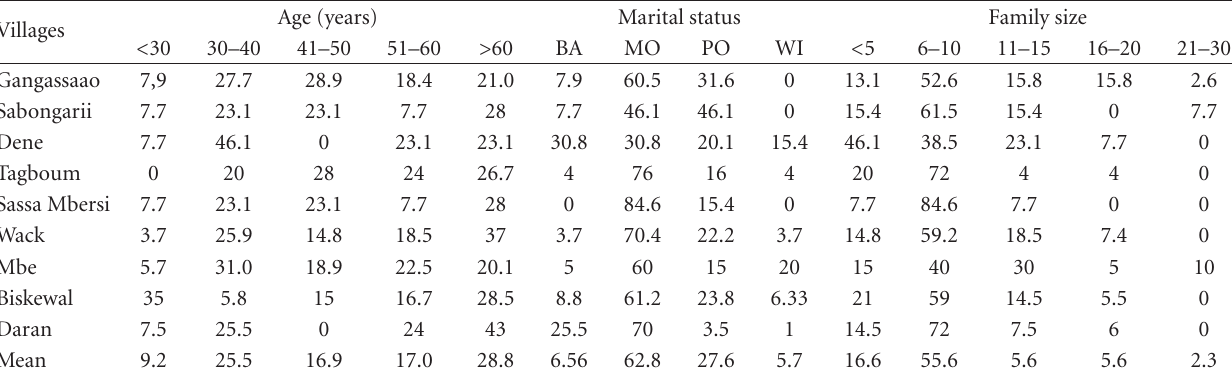
Table 1: Farmer percentages according to their socioeconomic characteristics (age, marital status, family size) in nine villages of the Guinean Highland Savannahs. BA; Bachelor, MO; Monogamy, PO; Polygamy, WI; Widow.